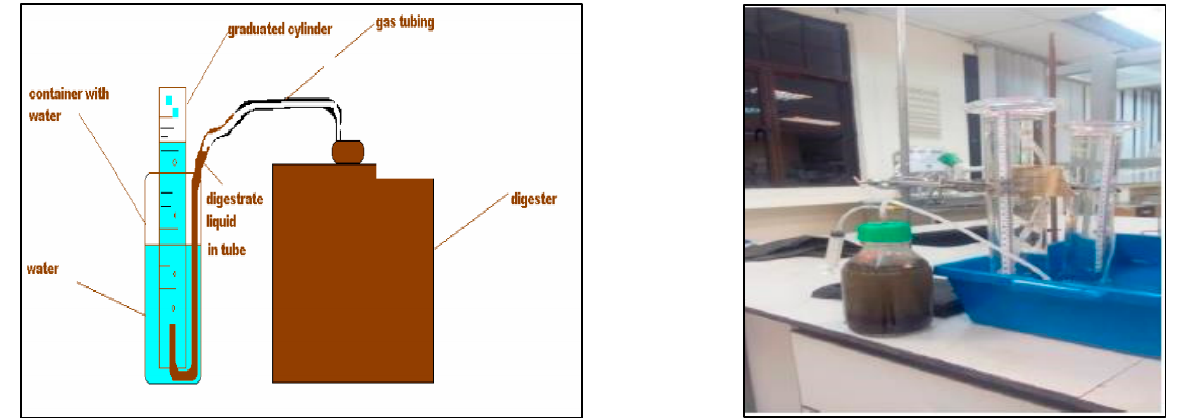
Figure 1. Schematic diagrams of gas measurement direct from a reactor using a cylinder meter di- gester.